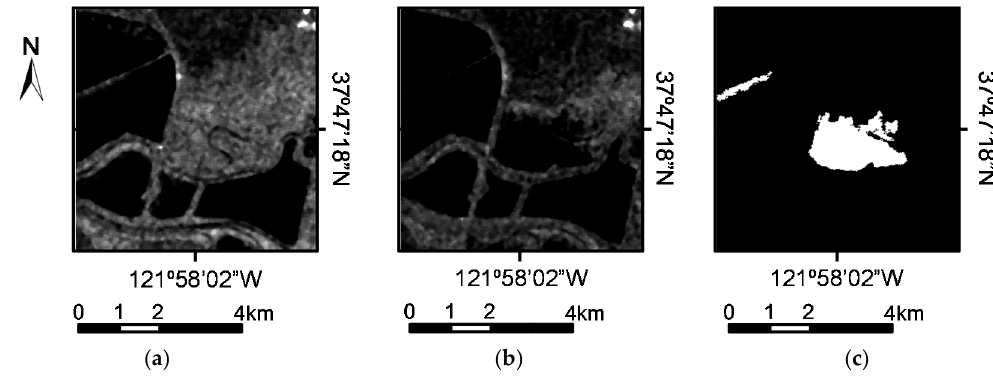
Figure 8. San Francisco dataset. ( a ) Image acquired in August 2003. ( b ) Image acquired in May 2004. ( c ) Ground truth change map created by integrating prior information with photo interpretation.